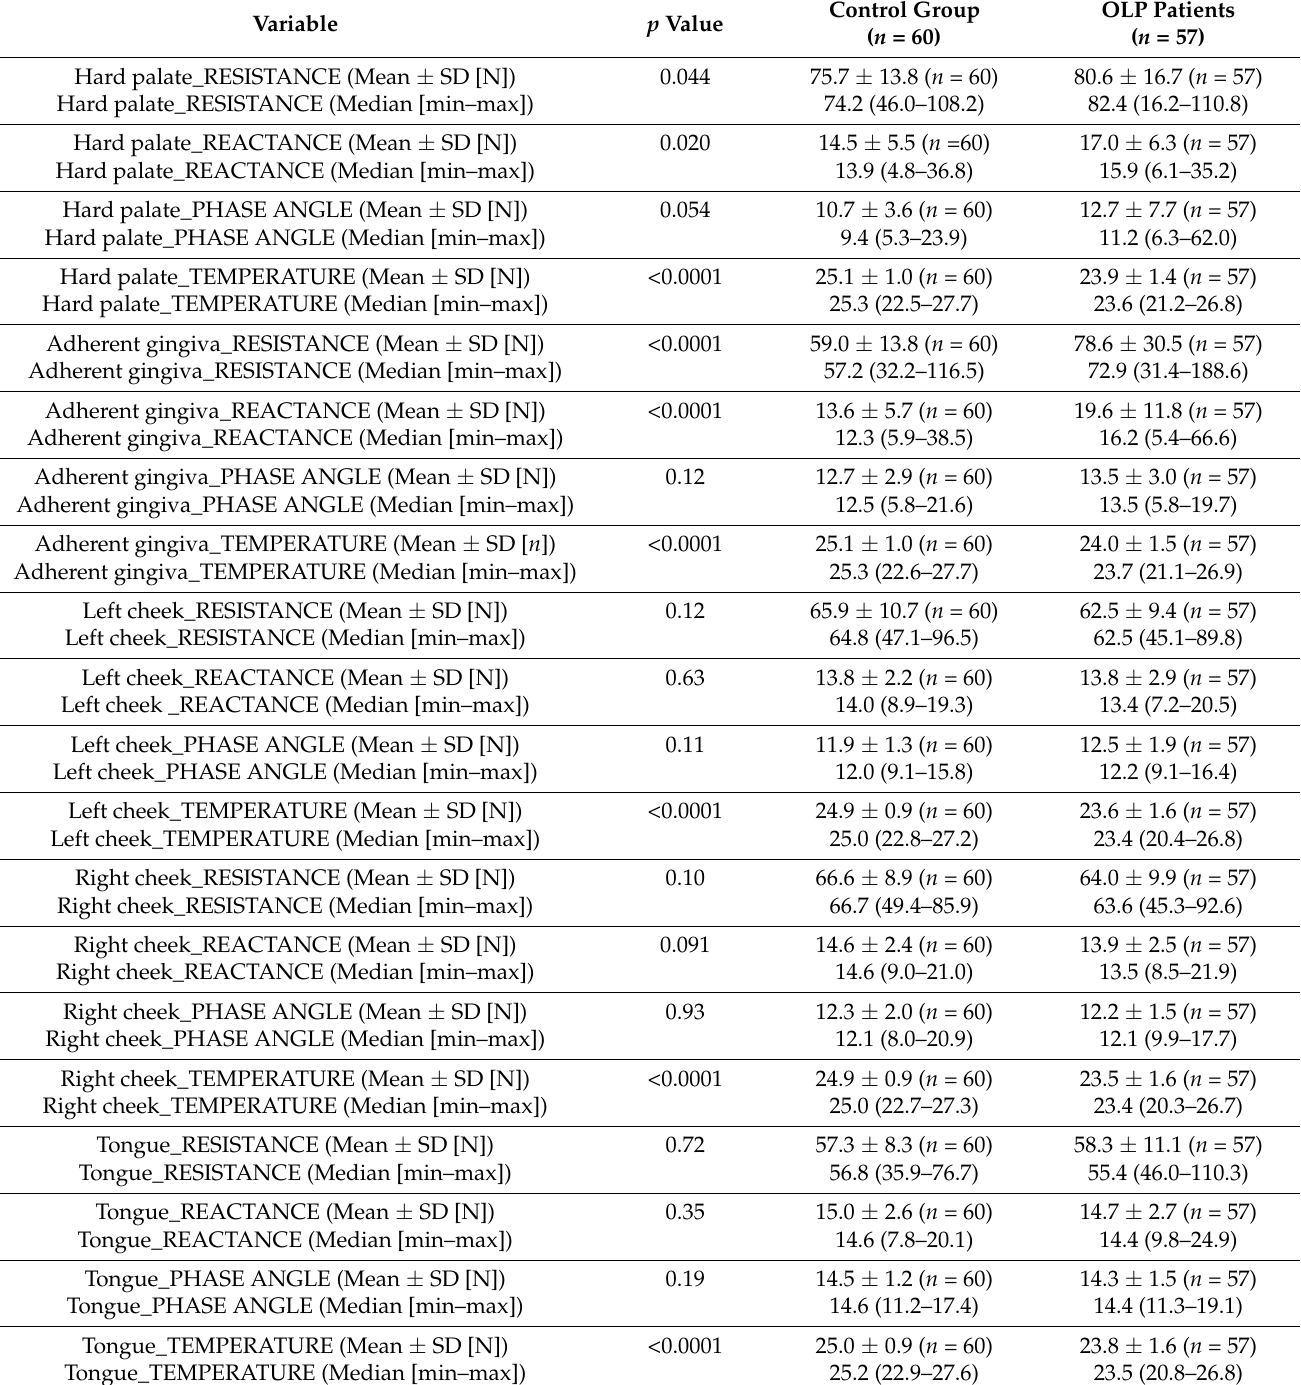
Table 1. Comparison between measurements in the OLP group and healthy controls (means